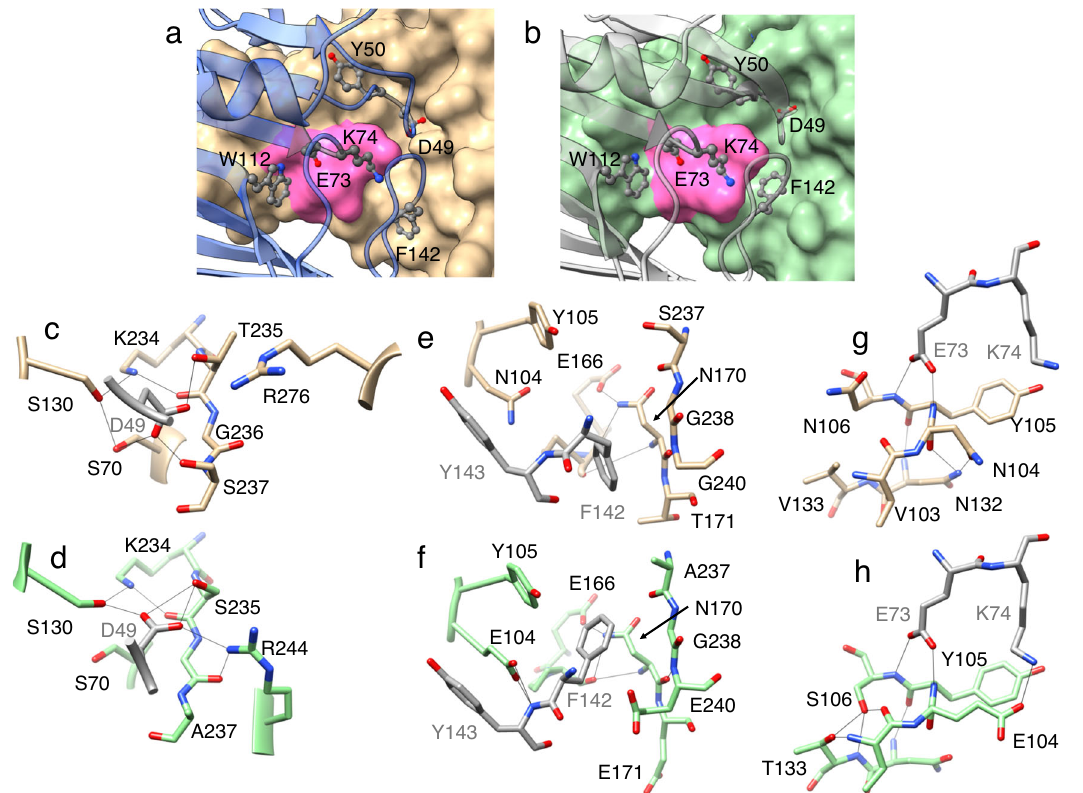
Fig.3|StructurediagramsofBLIPboundtoCTX-M-15andTEM-1 β -lactamases. a Active site region of CTX-M-15 β -lactamase (tan, surface representation), in complex with BLIP (blue, ribbon). Key BLIP residues are shown in gray ball-and- stick. Oxygen is shown in red and nitrogen in blue. The CTX-M-15 103-VNYN-106 loop is highlighted in pink. b Active site region of TEM-1 β -lactamase (green, sur- face),incomplexwithBLIP(PDBid:1JTG).KeyBLIPresiduesareshowningrayball- and-stick. The TEM-1 103-VEYS-106 loop is highlighted in pink. Panels a and b are shown in the same orientation as panels c - h . c BLIP Asp49 (gray) residue interac- tionswiththeactivesiteofCTX-M-15 β -lactamase(tan).Oxygenisshowninredand